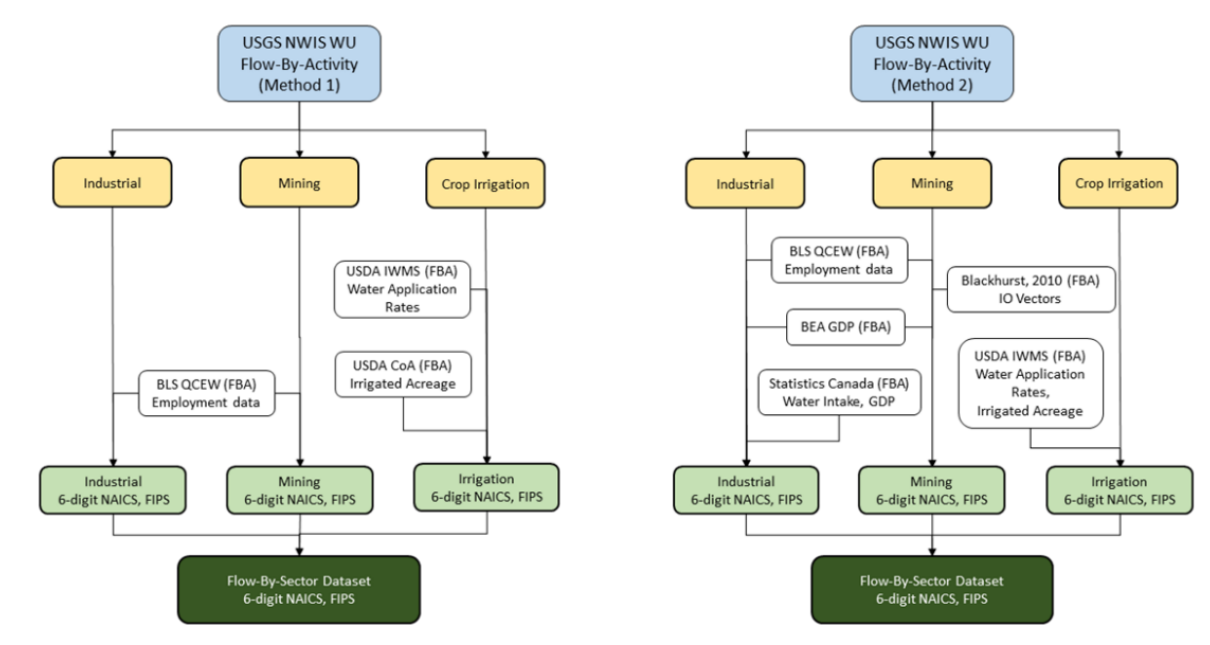
Figure 3. Comparison of the data sources used to generate the Method 1 and Method 2 National Water Withdrawal Flow-By-Sector datasets. FBA is defined as “Flow-By-Activity”. Data Sources: USGS NWIS WU, BLS QCEW, USDA IWMS, USDA CoA, BEA GDP, Statistics Canada, and Blackhurst IO Vectors.